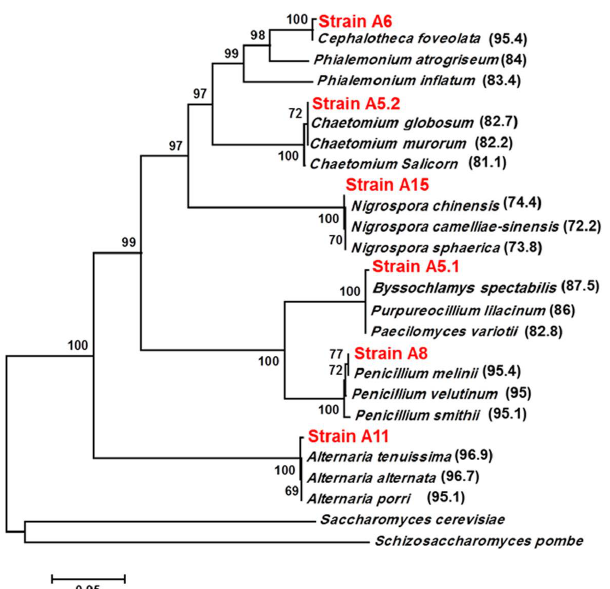
Figure 1. Phylogenetic tree for A5.1, A5.2, A6, A8, A11, A15 and related strains based on the ITS sequences. GenBank accession numbers of different ITS sequences used in constructing the phylogenetic tree are as follows: Byssochlamys spectabilis (MH512976), Purpureocillium lilacinum (KC157750), Paecilomyces variotii (AF033395), Chaetomium globosum (MN856296), Chaetomium sal- icorn (KR093181), Chaetomium murorum (KM268657), Cephalotheca foveolata (KJ573100), Phialemonium atrogriseum (AB540569), Phialemonium inflatum (MH859036), Penicillium melinii (MH858072), Peni- cillium velutinum (MH855309), Penicillium smithii (MH862076), Alternaria tenuissima (KM921667), Alternaria alternata (MK332247), Alternaria porri (JF422730), Nigrospora chinensis (KX985947), Nigrospora camelliae-sinensis (KX986015), Nigrospora sphaerica (JN198501), Saccharomyces cerevisiae (MG775707), and Schizosaccharomyces pombe (MH595429). The phylogenetic tree was constructed by the neighbor- joining method with 1000 replicates using MEGA7 software. Numbers in parentheses are the percentages of identity between the ITS sequences